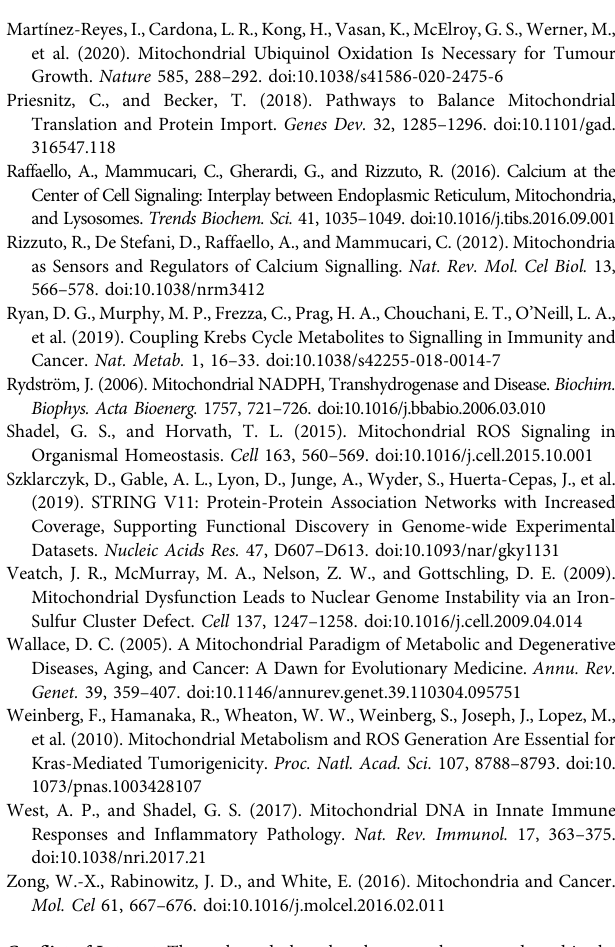
Supplementary Table 2 | A complete list of genes associated with the functional enriched pathways after 2.5 weeks of treatment. Genes within the bottom direction